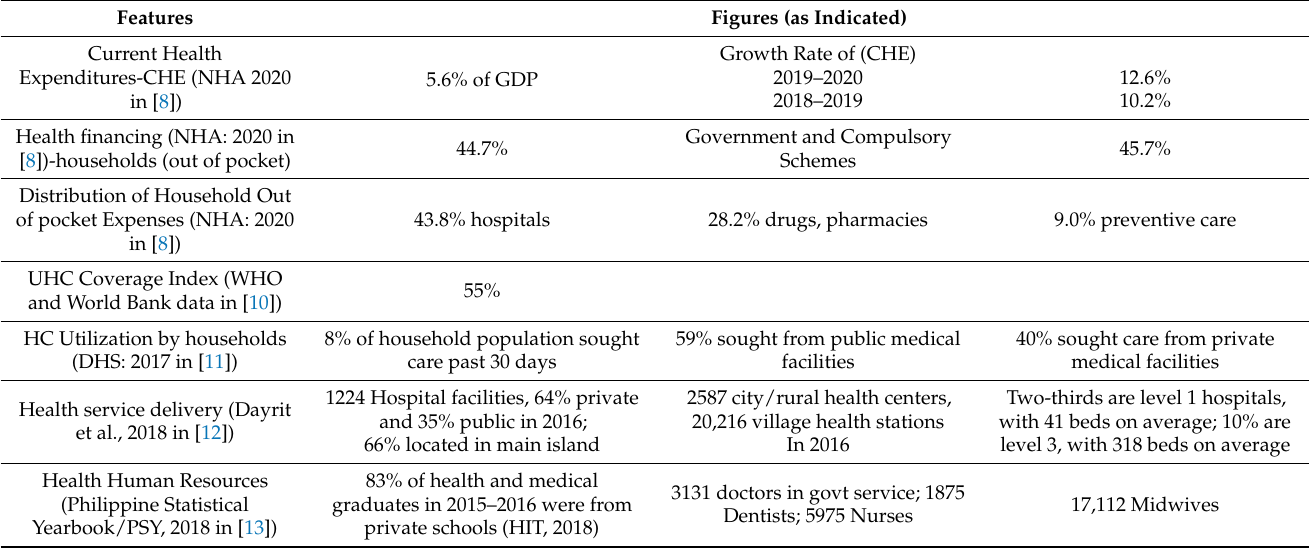
Table 1. Philippine Health System: Overview of Basic